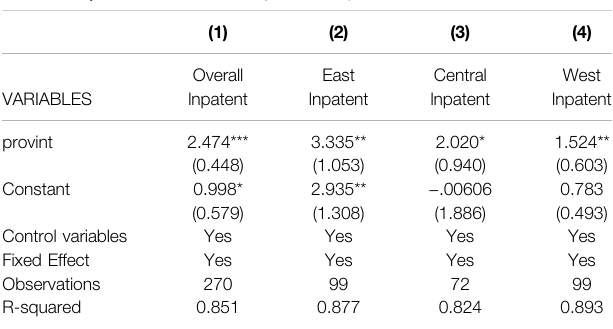
TABLE 10 | Robustness test of adjusted sample interval.